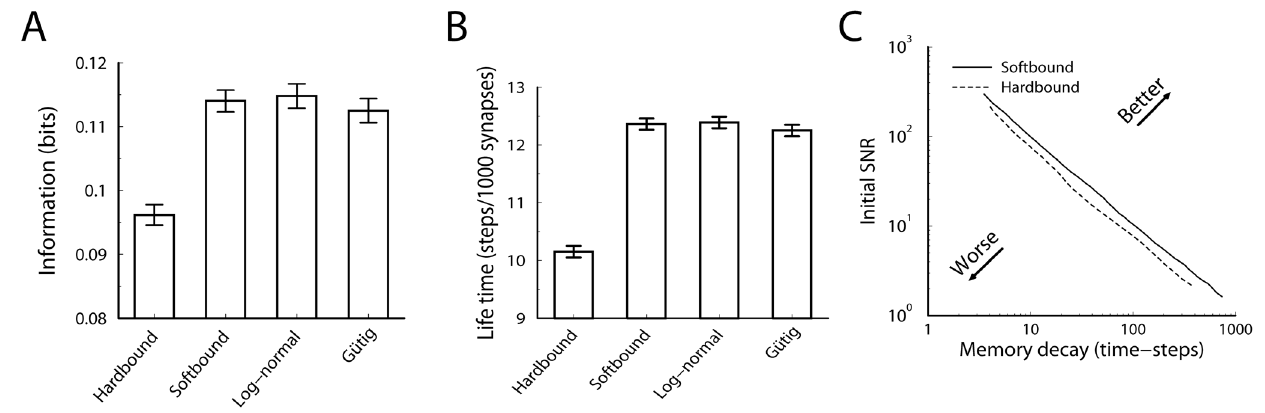
Figure 3. Comparison of hard-bound to soft-bound plasticity. A) The information capacity per synapse in the recognition task for a variety of plasticity rules. Up to numerical error, the soft-bound, log-normal and Gutig rule perform identically. B) Simulation of the lifetime of a memory for various plasticity rules. The lifetime was defined as the number of memories stored with a SNR above 30. Again soft-bound plasticity outperforms hard-bounds. C) The trade-off between memory decay time and initial memory strength for soft- and hard-bound plasticity. The amount of synaptic update was varied and the resulting fitted decay time-constant and the initial SNR was plotted. Ideally initial strength is high and memory decay time is long (top-right corner), but increasing one decreases the other. Soft-bound plasticity always leads to a superior